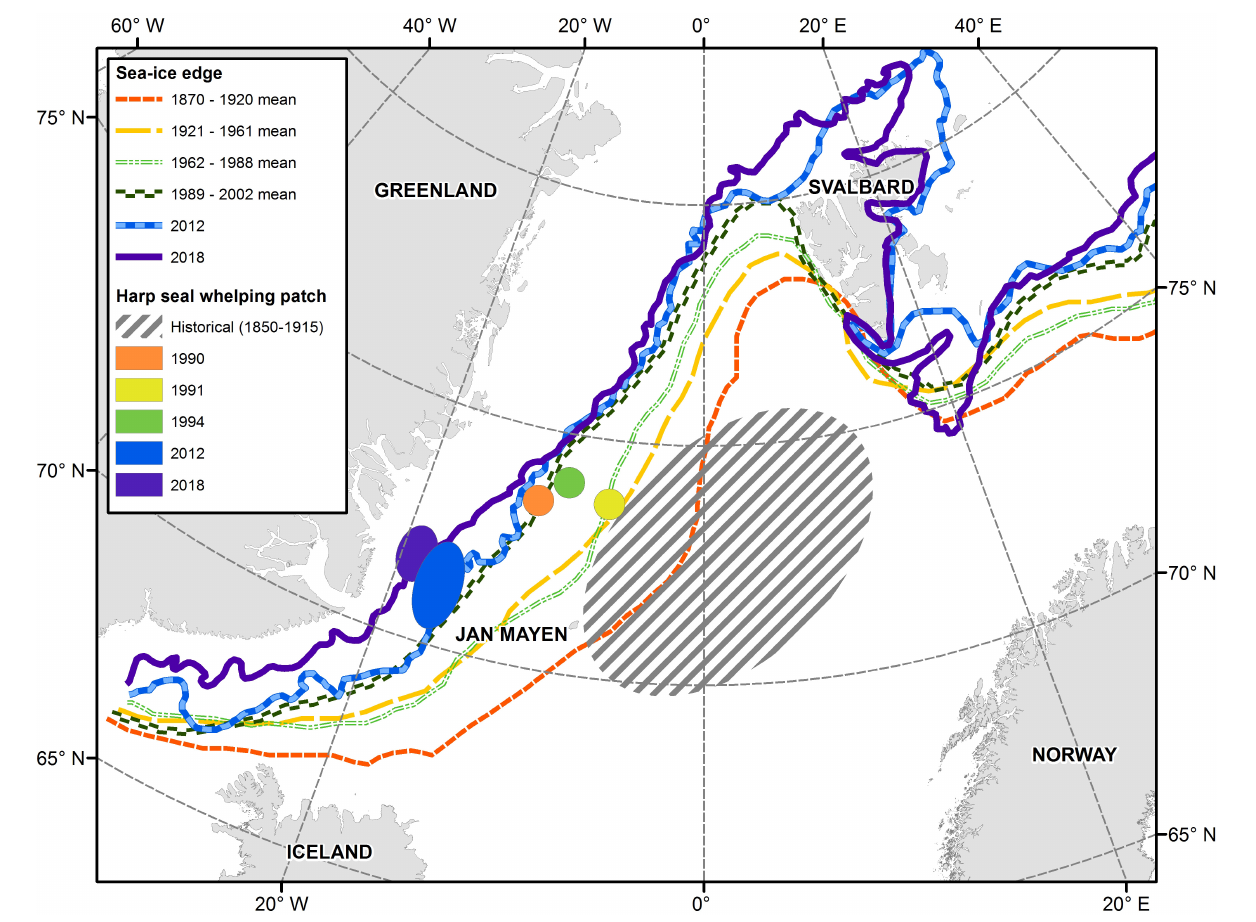
FIGURE 7 | Location of sea ice edge and the Greenland Sea harp seal whelping concentrations. Historical ice data from Divine and Dick (2006). Recent ice data and whelping locations from Øritsland and Øien (1995); Øigård et al. (2014) and International Council for the Exploration of the Sea [ICES] (2019b).